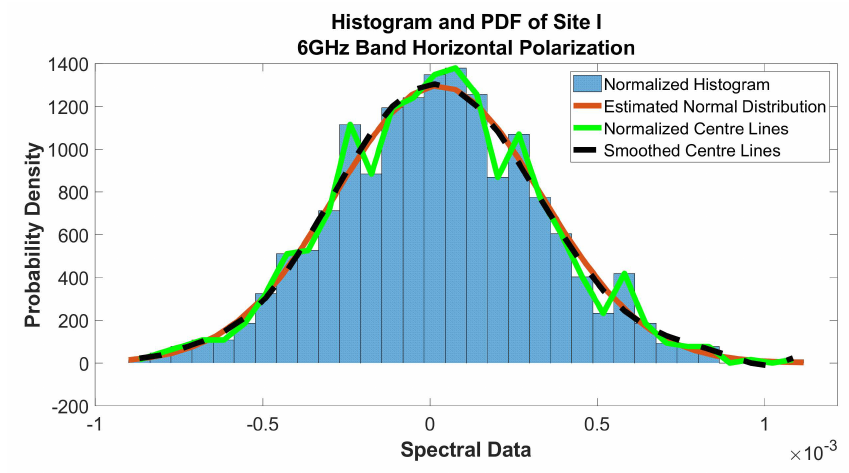
Figure 51. Histogram and PDF of site I at 6 GHz band horizontal polarization.